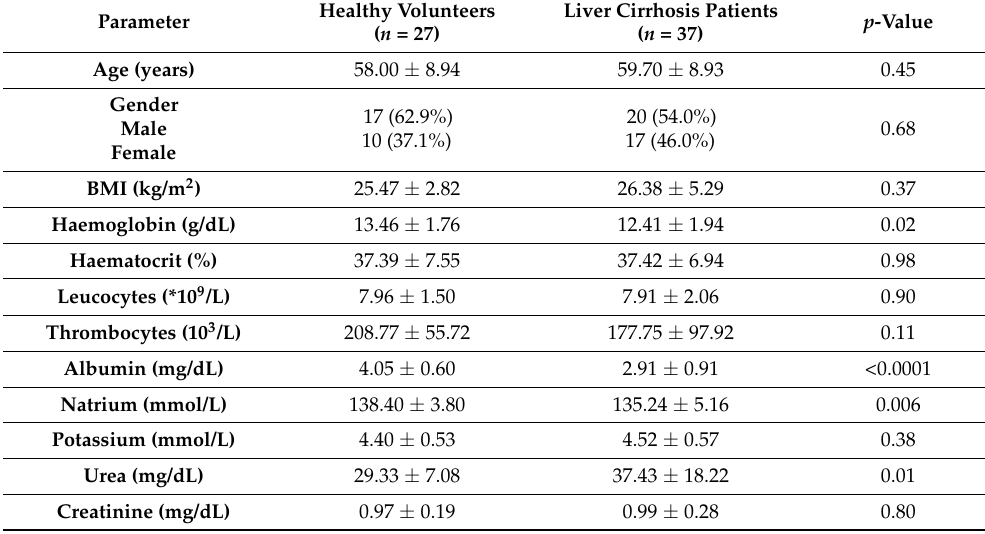
Table 1. Clinical and biochemical characteristics of the study